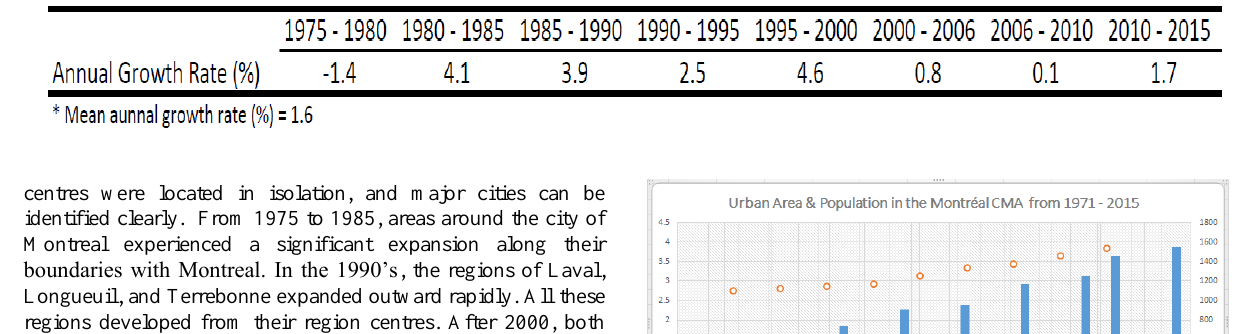
Fig. 3 . Urbanization multi-temporal change map for the Montréal CMA from 1975 to 2015 with 10-year intervals Table 5 . Annual urban growth rate from 1975 to 2015 in the Montréal CMA